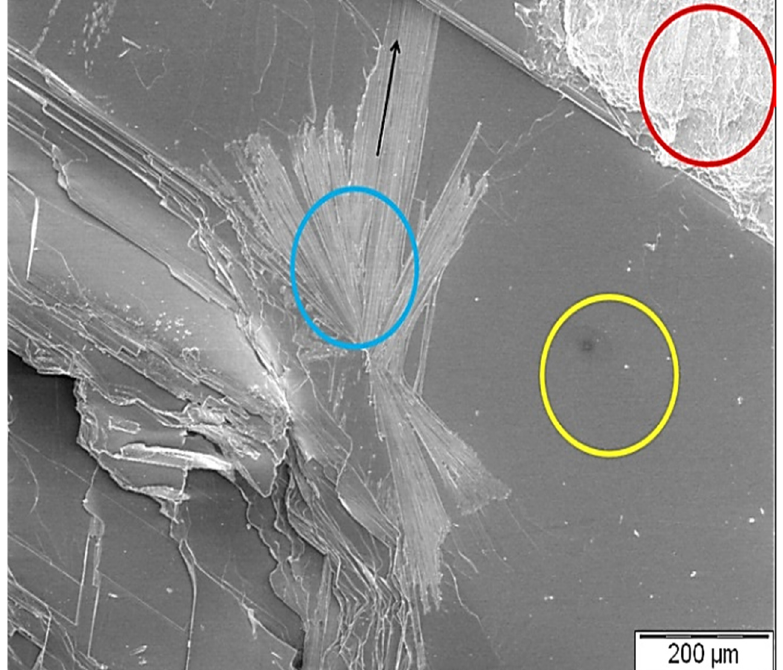
Figure 7. Gypsum crystal partly dehydrated, cleaved along cleavage plane, with observable dihydrate, α -hemihydrate and β -hemihydrate. Yellow circle = still dihydrate, blue circle = alpha hemihydrate, red circle = beta hemihydrate, black arrow = alpha hemihydrate growing direction of a needle like crystal Points 4 and 5 are comparable to the gypsum crystal without heat treatment. The measured values did not perfectly fit the calculated values because of the error of meas- urement of EDX.